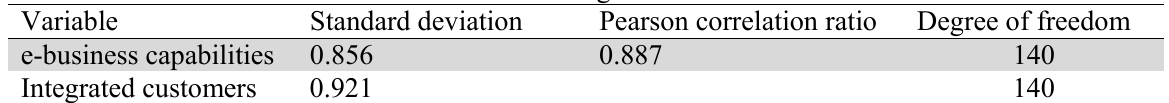
Pearson correlation test between e-business and integrated customer